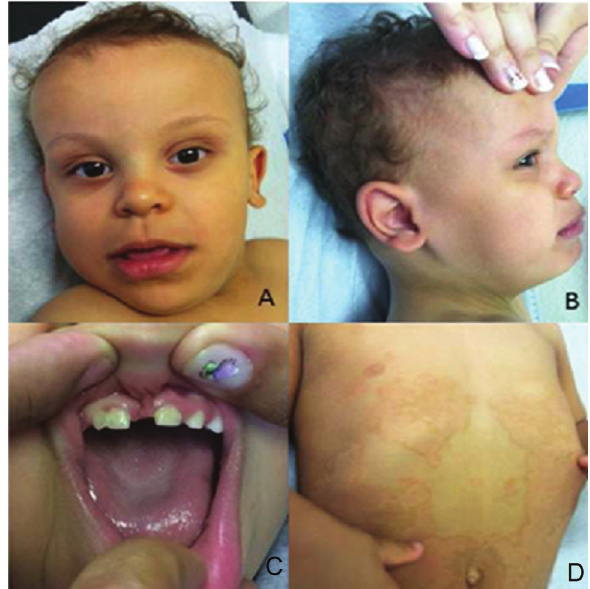
Figure1 -A-D.Fine,sparsehairinthetemporalregions,proeminentfore- head, ocular hypertelorism, upslanting palpebral fissures, everted lower lip, small, widely-spaced teeth, diastema and fusion of the central and lat- eral right inceisors, uplifted ear lobes; short neck; hyperchromic/icthyo- siform skin lesions, geographic lesions with hyperpigmented borders in the thorax and abdominal